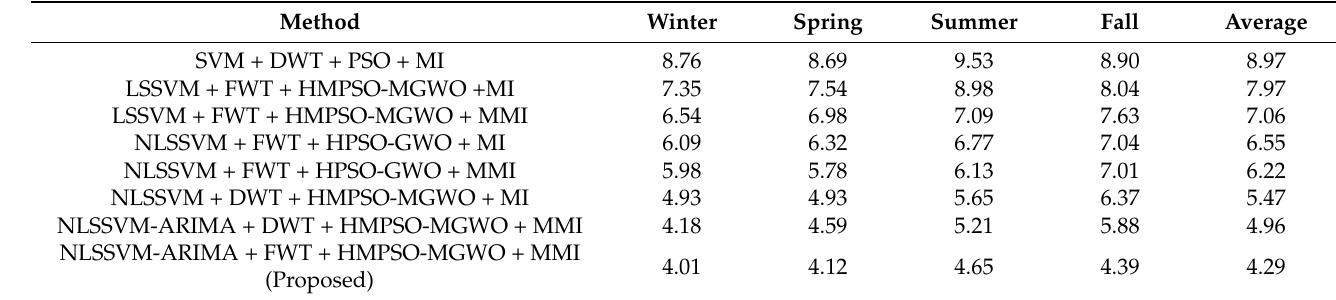
Table 5. Proposed models formed on MAPE criterion, their various combinations to study the performance of signal decomposition and data selection methods. Method Winter